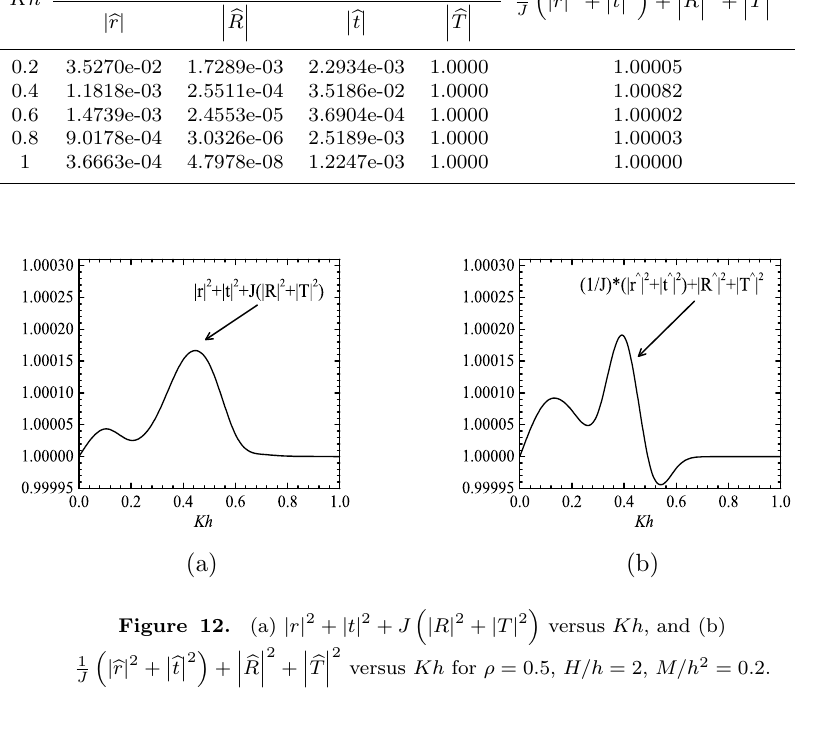
(cid:12) (cid:12) (cid:12) (cid:12) (cid:17) 2 2 (cid:12) (cid:12) (cid:12)(cid:98) T (cid:12) (cid:12) versus Kh for ρ = 0 . 5, H/h = 2, M/h 2 = 0 . + + (cid:12) (cid:12) (cid:12) (cid:98) R